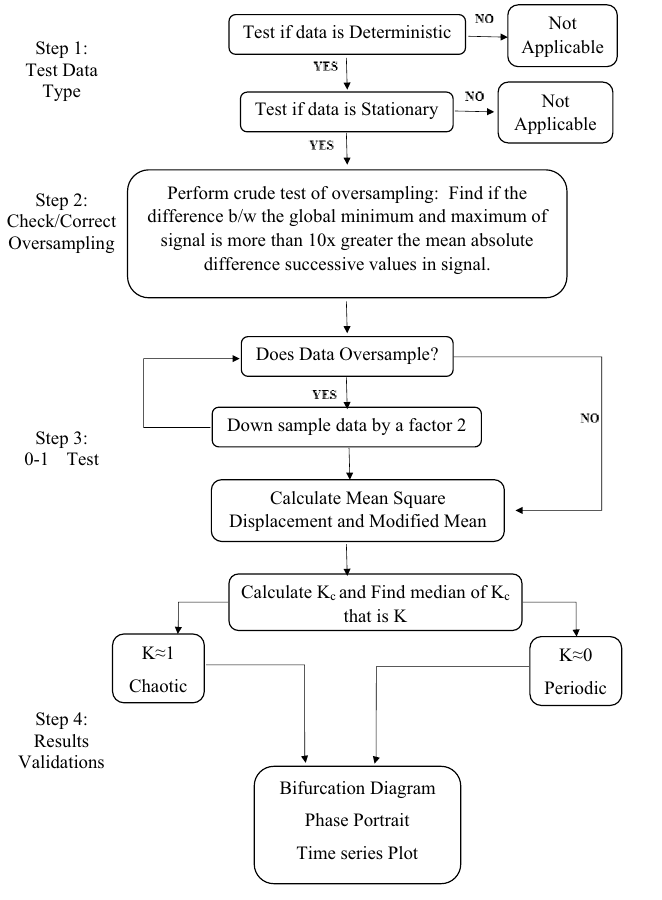
Figure 2. Flow chart of research